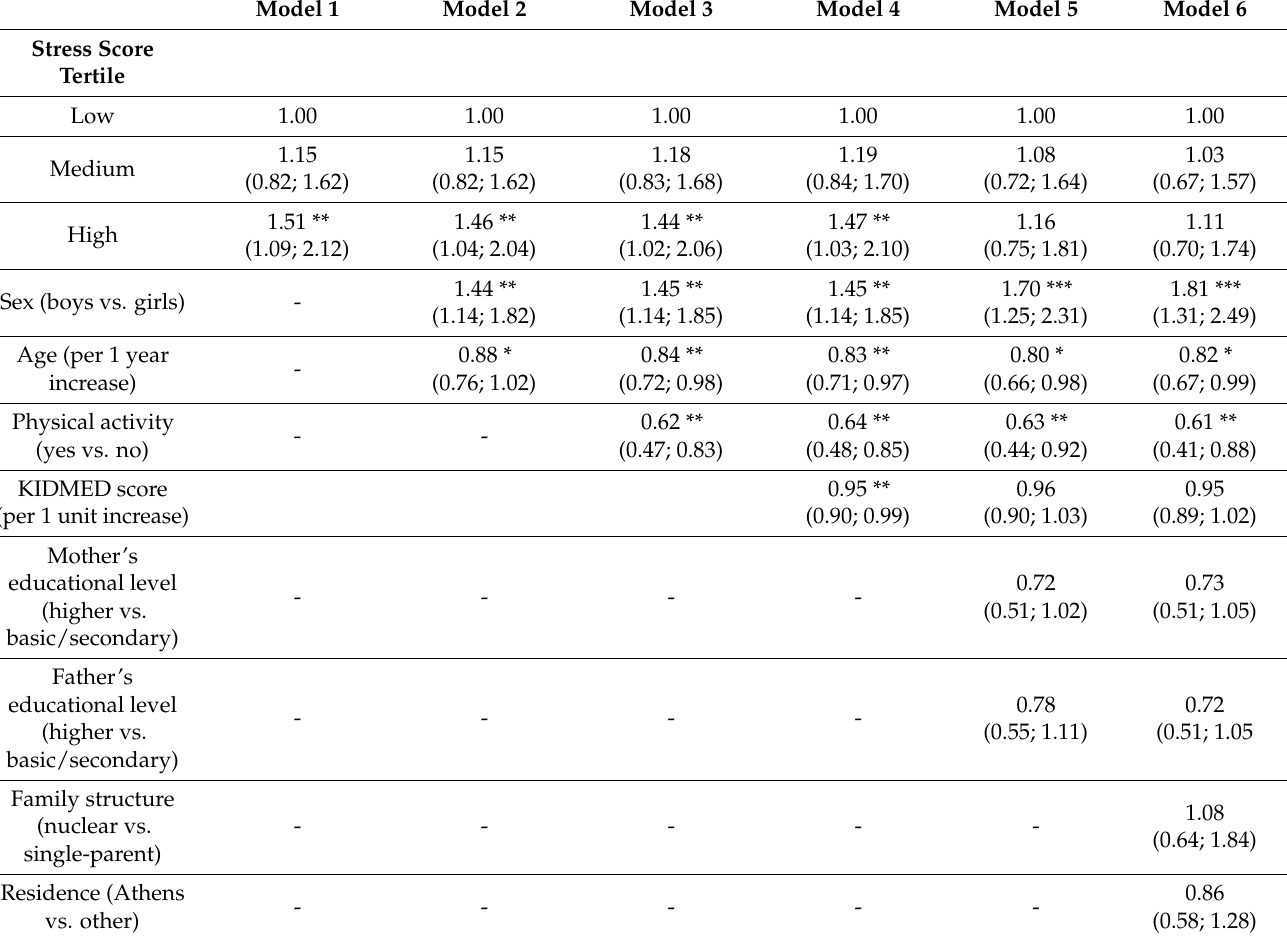
Table 4. Results from nested logistic regression models (OR, 95% CI) that evaluated the association between stress and children’s weight status category (overweight/obese vs. normal), adjusted for several